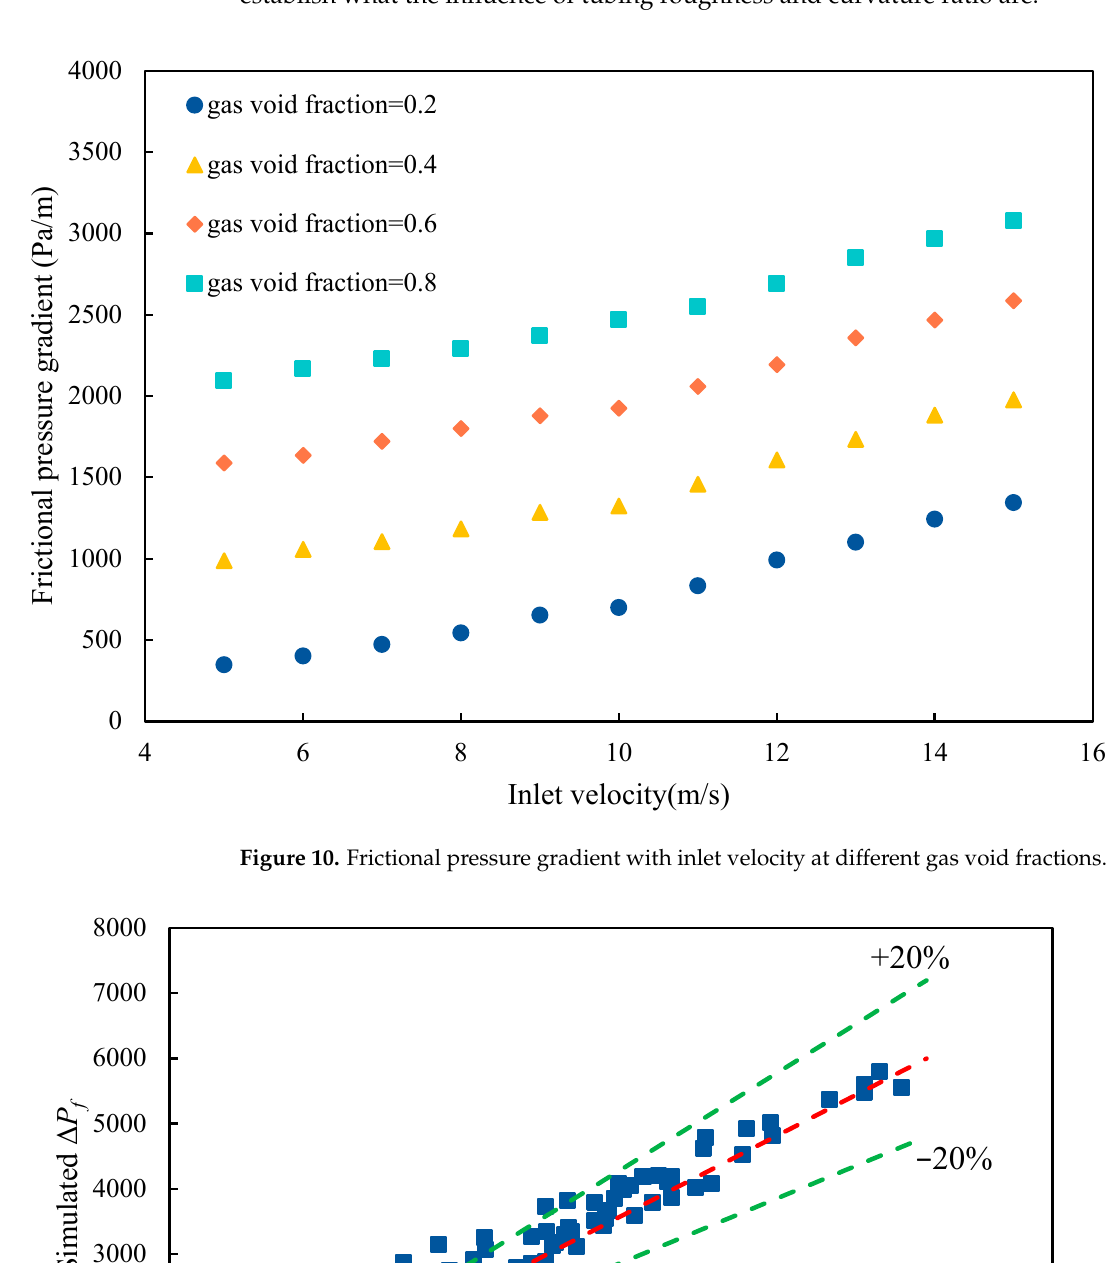
11 of 13 Figure 9. Average frictional pressure gradient with average Dean number. 3.5. Effect of Inlet Velocity on Frictional Pressure Losses The inlet velocity was set to 5 m/s, 6 m/s, 7 m/s, and… 15 m/s; the gas void fraction was set to 0.2, 0.4, 0.6 and 0.8, respectively; and flow in M2 coiled tubing was simulated.